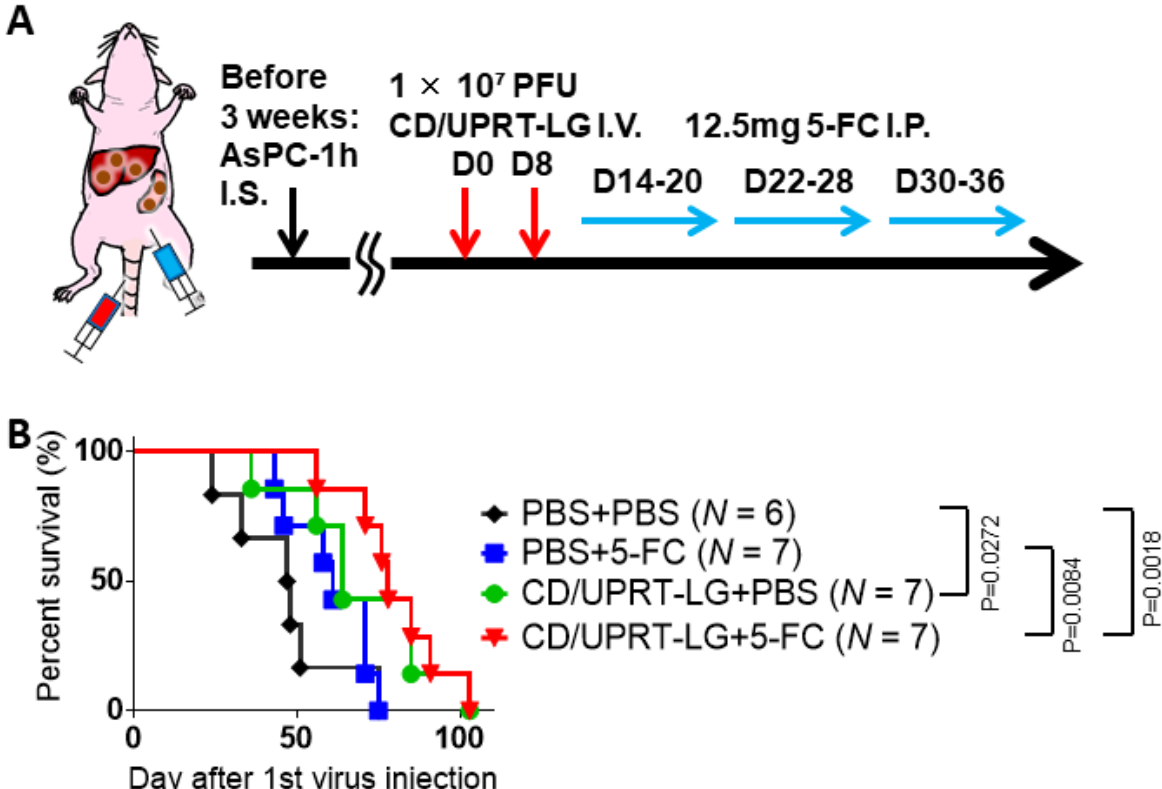
Figure 6. Combination treatment with mitogen-activated protein kinase-dependent recombinant vaccinia virus (MDRVV) (CD/UPRT-LG) and 5-fluorocytosine (5-FC) increases the therapeutic effect in a mouse model harboring liver metastasis caused by human pancreatic ductal adenocarcinoma cells. ( A ) Schematic representation of the study design and timeline of tumor growth and viral distribution. ( B ) The nude mice with liver metastasis were intravenously injected with 1 × 10 7 PFU of MDRVV (CD/UPRT-LG) on days 0 and 8. Next, 12.5 mg 5-FC was injected intraperitoneally into the mice every day from days 14 to 36, except on days 21 and 29. Survival curves of mice were generated by Kaplan–Meier analysis ( n = 6–7) and p values were determined using the log-rank test.